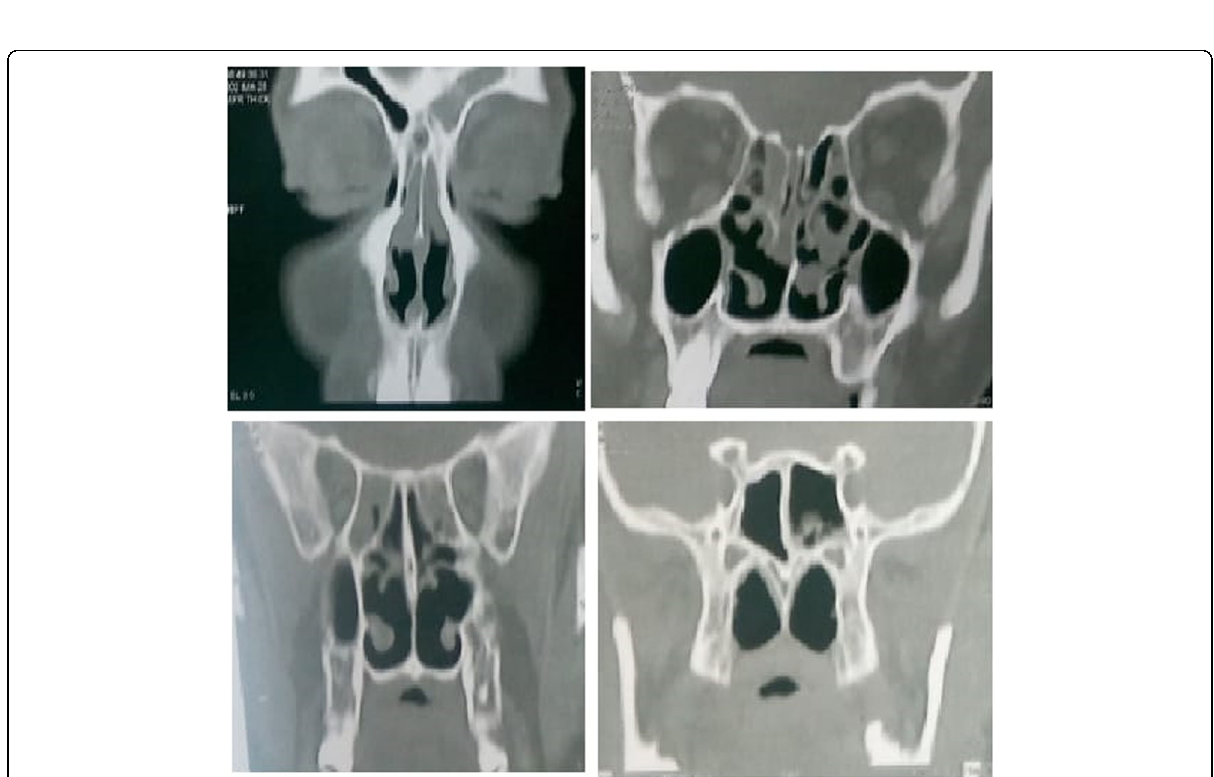
Fig. 10 CT PNS of the same patient after 3 intrapolyp steroid injection, showing partial